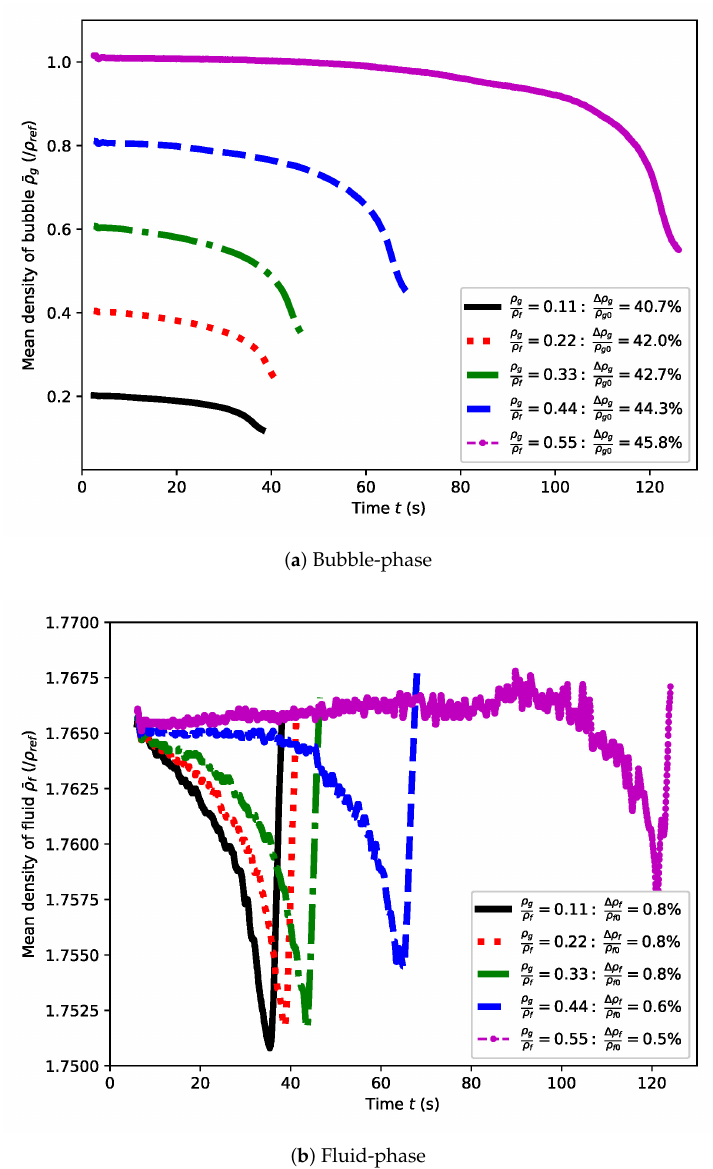
Figure 8. The mean densities ¯ ρ of the bubble ( a ) and the surrounding fluids ( b ) for different density ratios ρ g = 0.11 − ρ f